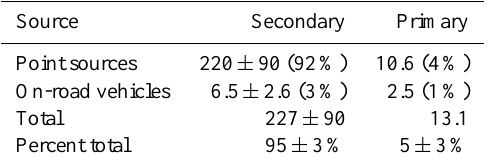
Table 4. Summary of the rates of secondary production and primary emission of CH 2 O in HGB given as 24-h averages with estimated 1- σ confidence limits. The percentages in parentheses indicate rel- ative contributions to the total (primary + secondary) rate. Units of absolute rates are kmolh − 1 and uncertainties of primary emissions are estimated as ±